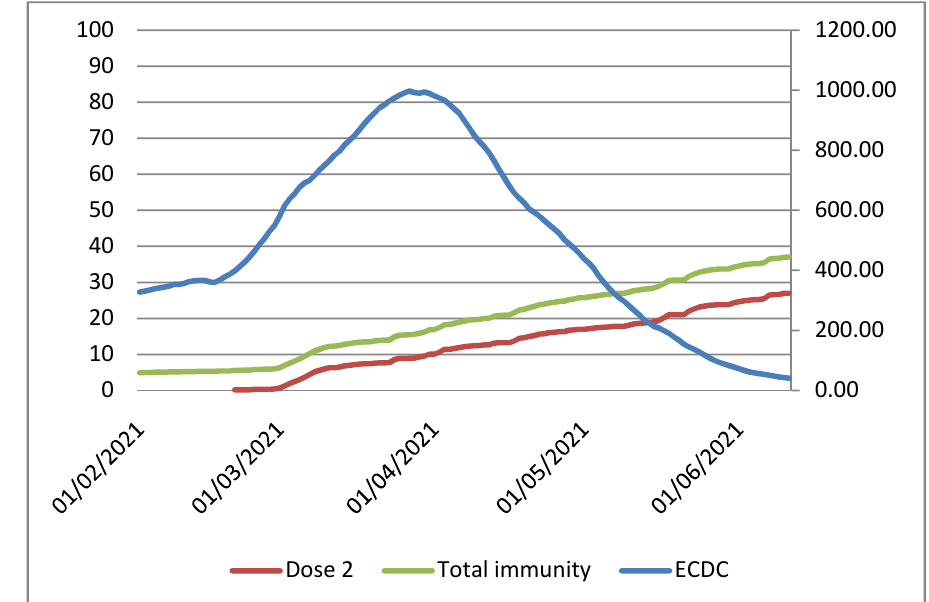
Figure 7 – INSTRUMENT 4: Immunization process in Serbia. Total immunity represents the number of the vaccinated with dose 2 plus the number of those recovered from Covid-